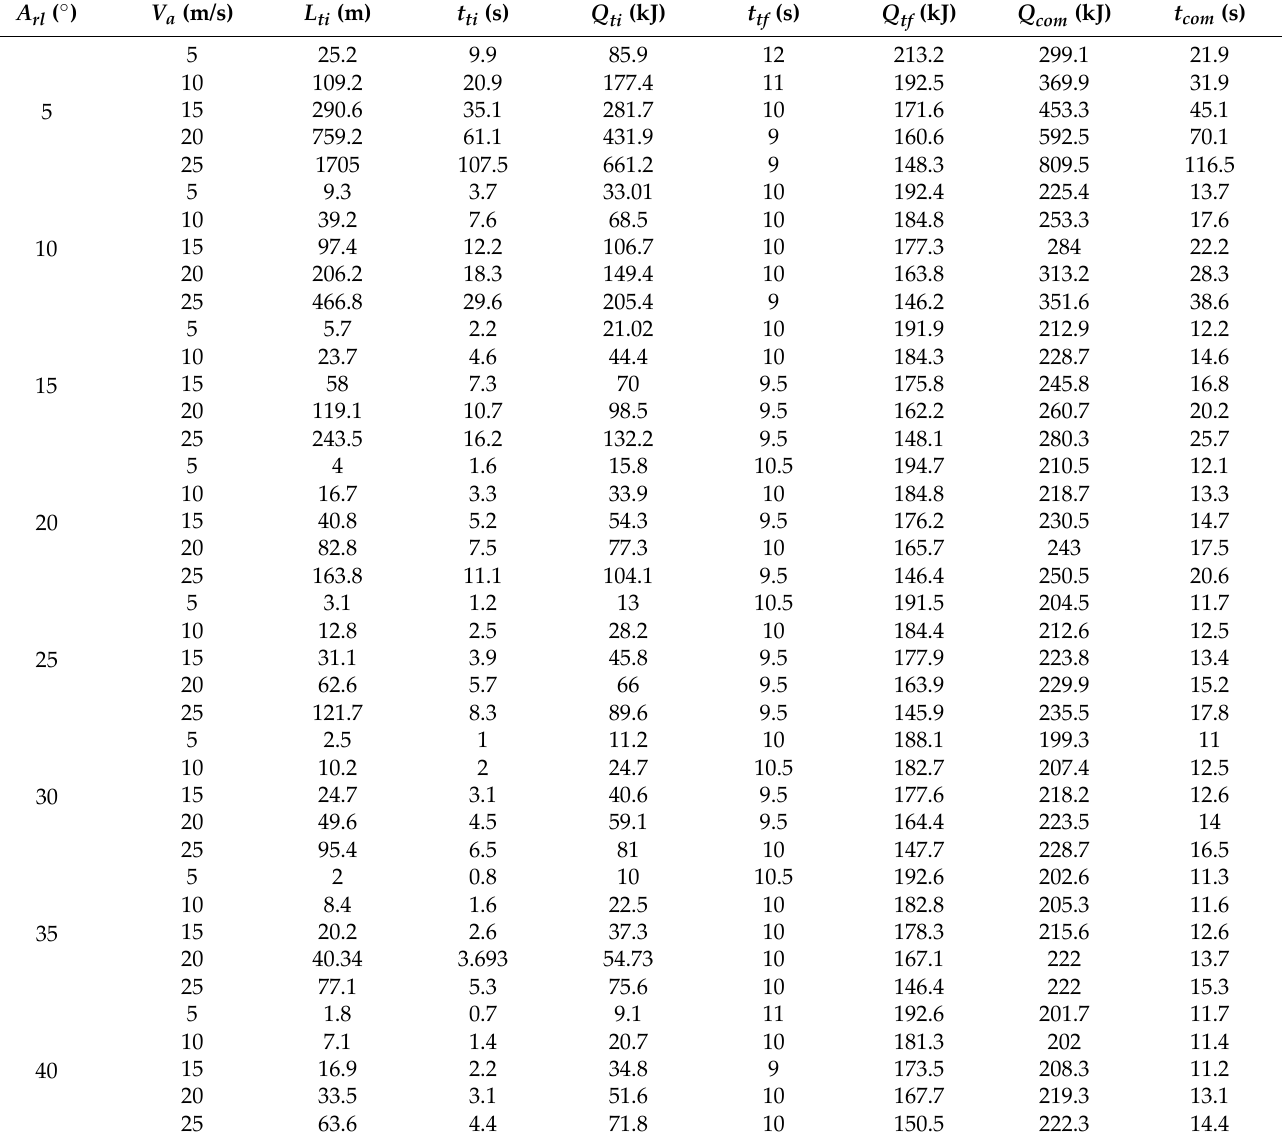
Table 3. UAV variables in